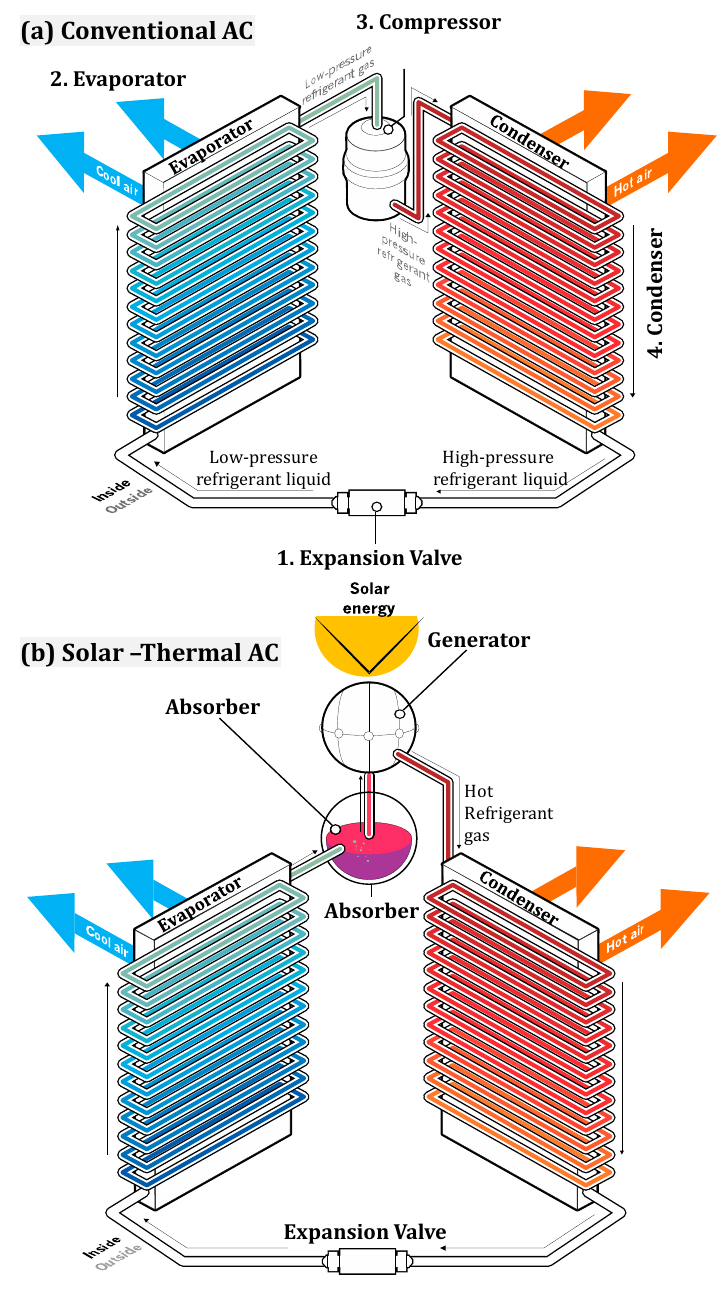
Figure 1. Schematic diagram and working principle of ( a ) conventional vapor compression air-conditioning system, and ( b ) solar thermal liquid desiccant dehumidification-based air-conditioning system, reproduced from [50].